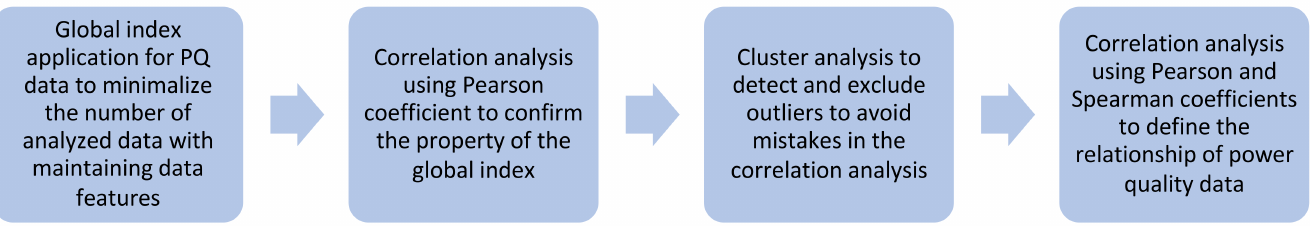
Figure 1. Summary of the proposed methodology with the expected